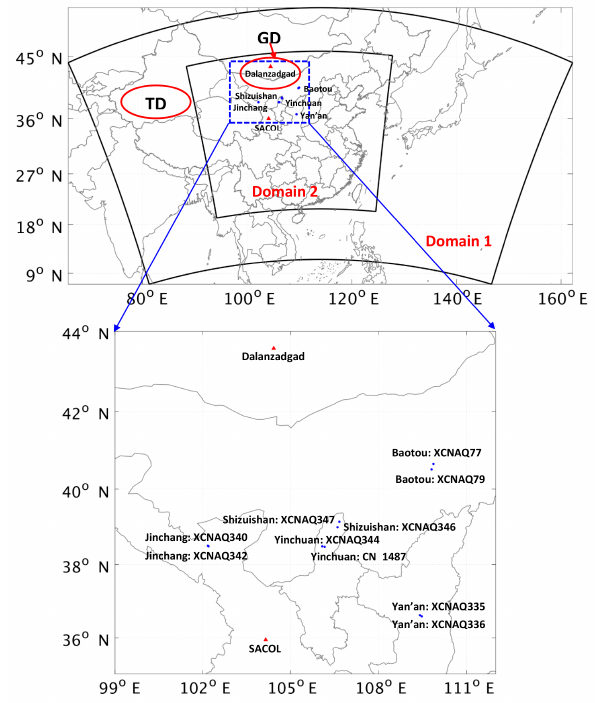
Figure 1. Nested domain set for the simulations. Blue dots repre- sent the 10 monitoring stations used for model validation. TD: the Taklimakan Desert; GD: the Gobi